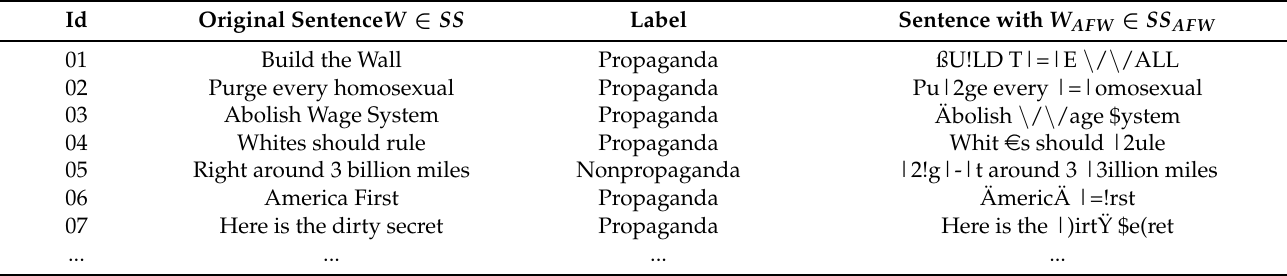
Table 7. An excerpt of the propaganda related dataset.